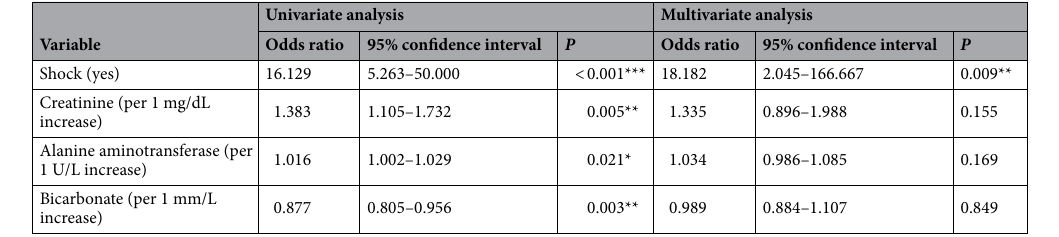
Table 6. Cox regression analysis for mortality (n = 71). *P < 0.05; ** P < 0.01; *** P < 0.001.